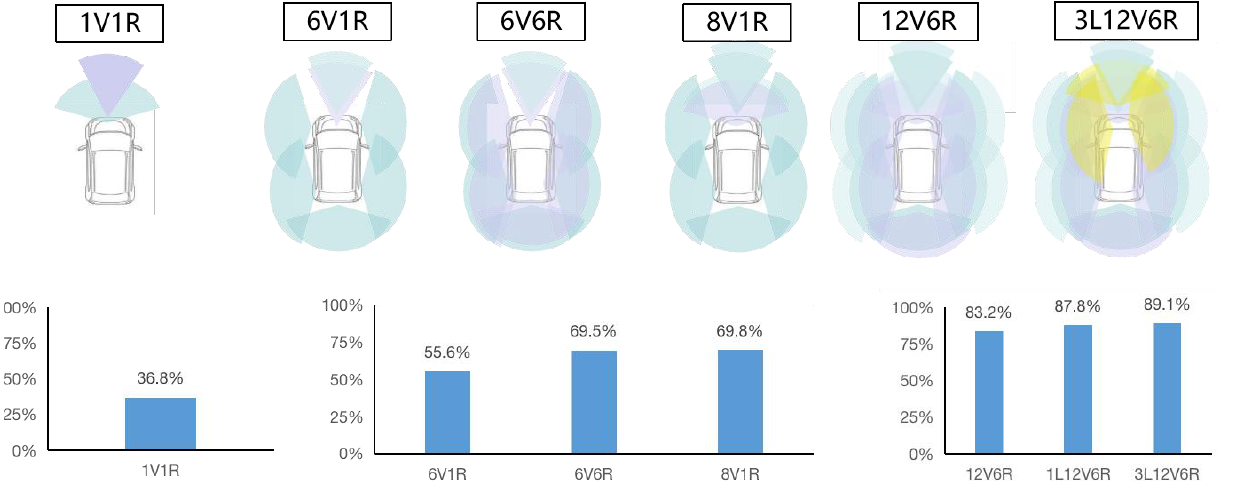
Figure 4. Comprehensive collision avoidance effectiveness of vehicle-side “atomic” technology combinations based on autonomous vehicles (V stands for vision, that is, cameras; Light blue stands for camera, light purple stands for radar, light yellow stands for